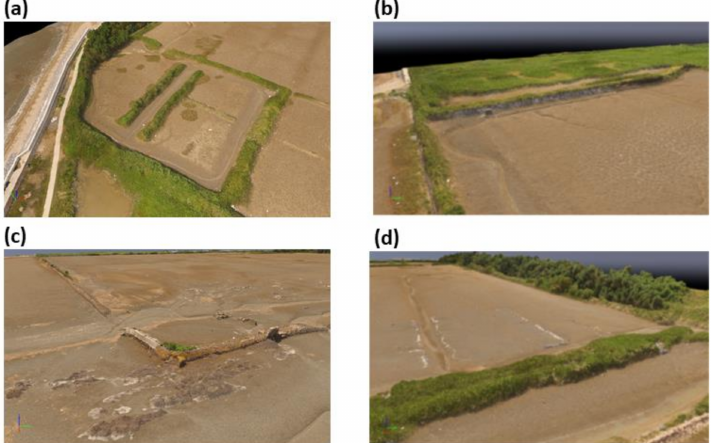
Figure 5. Northwestern embankment where the plant communities developed ( a ); the southwestern embankment and seawater passage ( b ); the destroyed southwestern embankment ( c ); the destroyed southeastern embankment of the unused saltern in the tidal flat of Yubu Island ( d ).